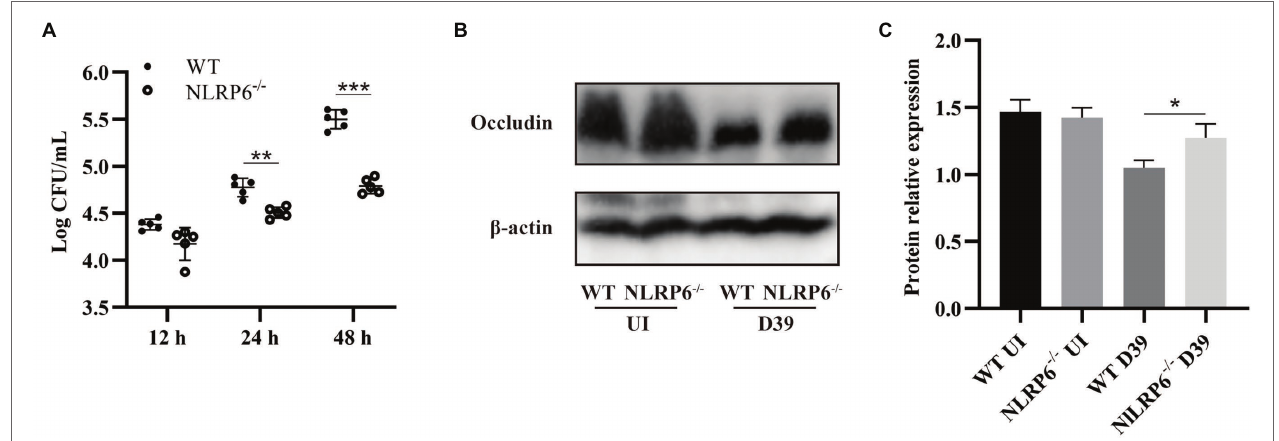
FIGURE 1 | NLRP6 deficiency reduces lung bacterial burden and maintains tight junction protein expression during S. pneumoniae infection. WT and NLRP6 − / − mice were intranasally infected with S. pneumoniae (5 × 10 7 CFU). (A) Lungs were harvested and colony counting was performed at 12 h, 24 h, and 48 h post- infection ( n = 5/group). (B) Lung tissue lysates were collected at 24 h post-infection and were analyzed by western blot to detect expression of occludin ( n = 5/group). Ratio of occludin levels against β -actin levels was quantified (C) . Statistical significance was shown as * p < 0.05, ** p < 0.01, and *** p <